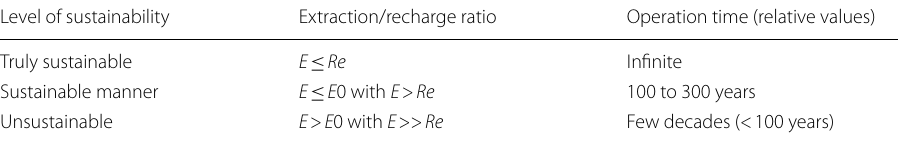
Table 1 Level of sustainability in dependence of extraction/recharge ratio Level of